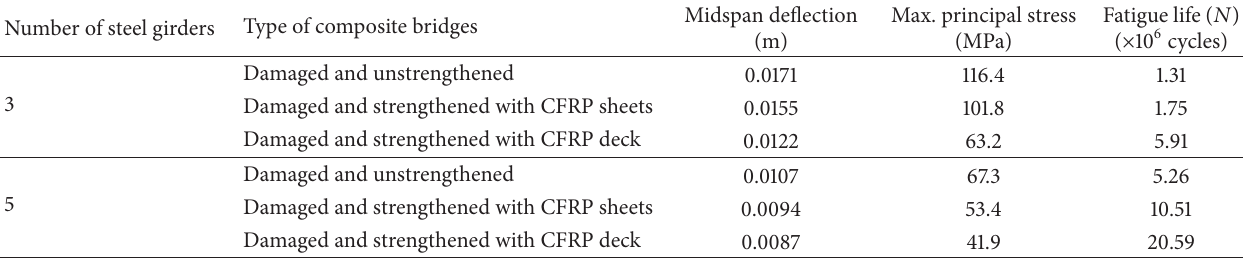
Table 7: Full results of FE analyses of damaged (with 6 mm crack) composite